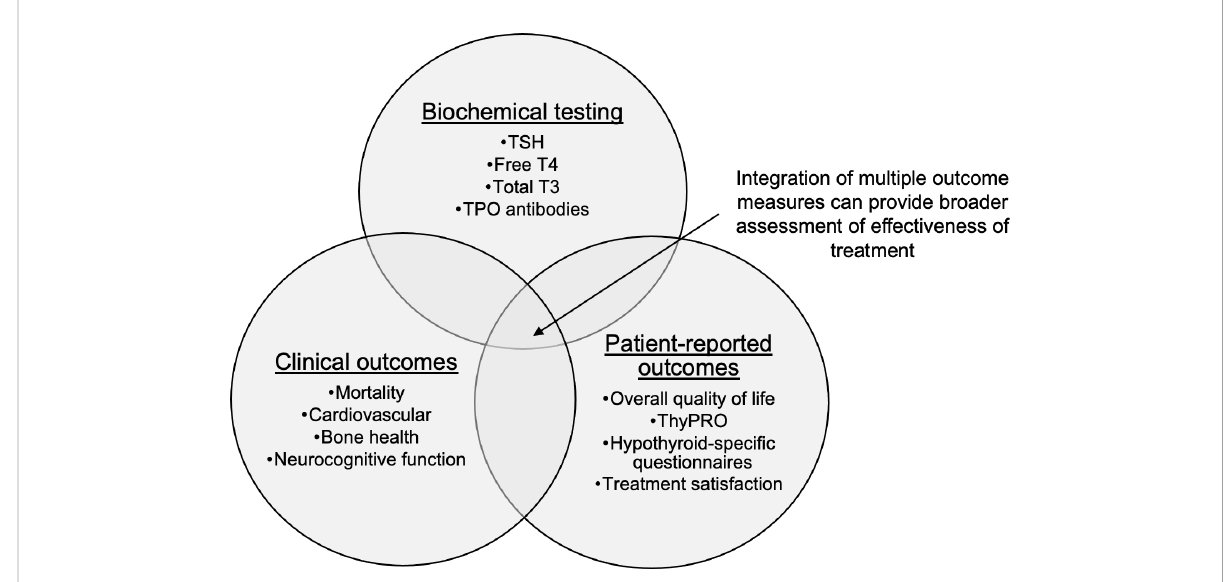
FIGURE 2 Intersection of health outcomes hypothyroidism research. TSH, thyrotropin; T4, thyroxine; T3, triiodothyronine; TPO, thyroid peroxidase; ThyPRO, thyroid speci fi c patient reported outcome